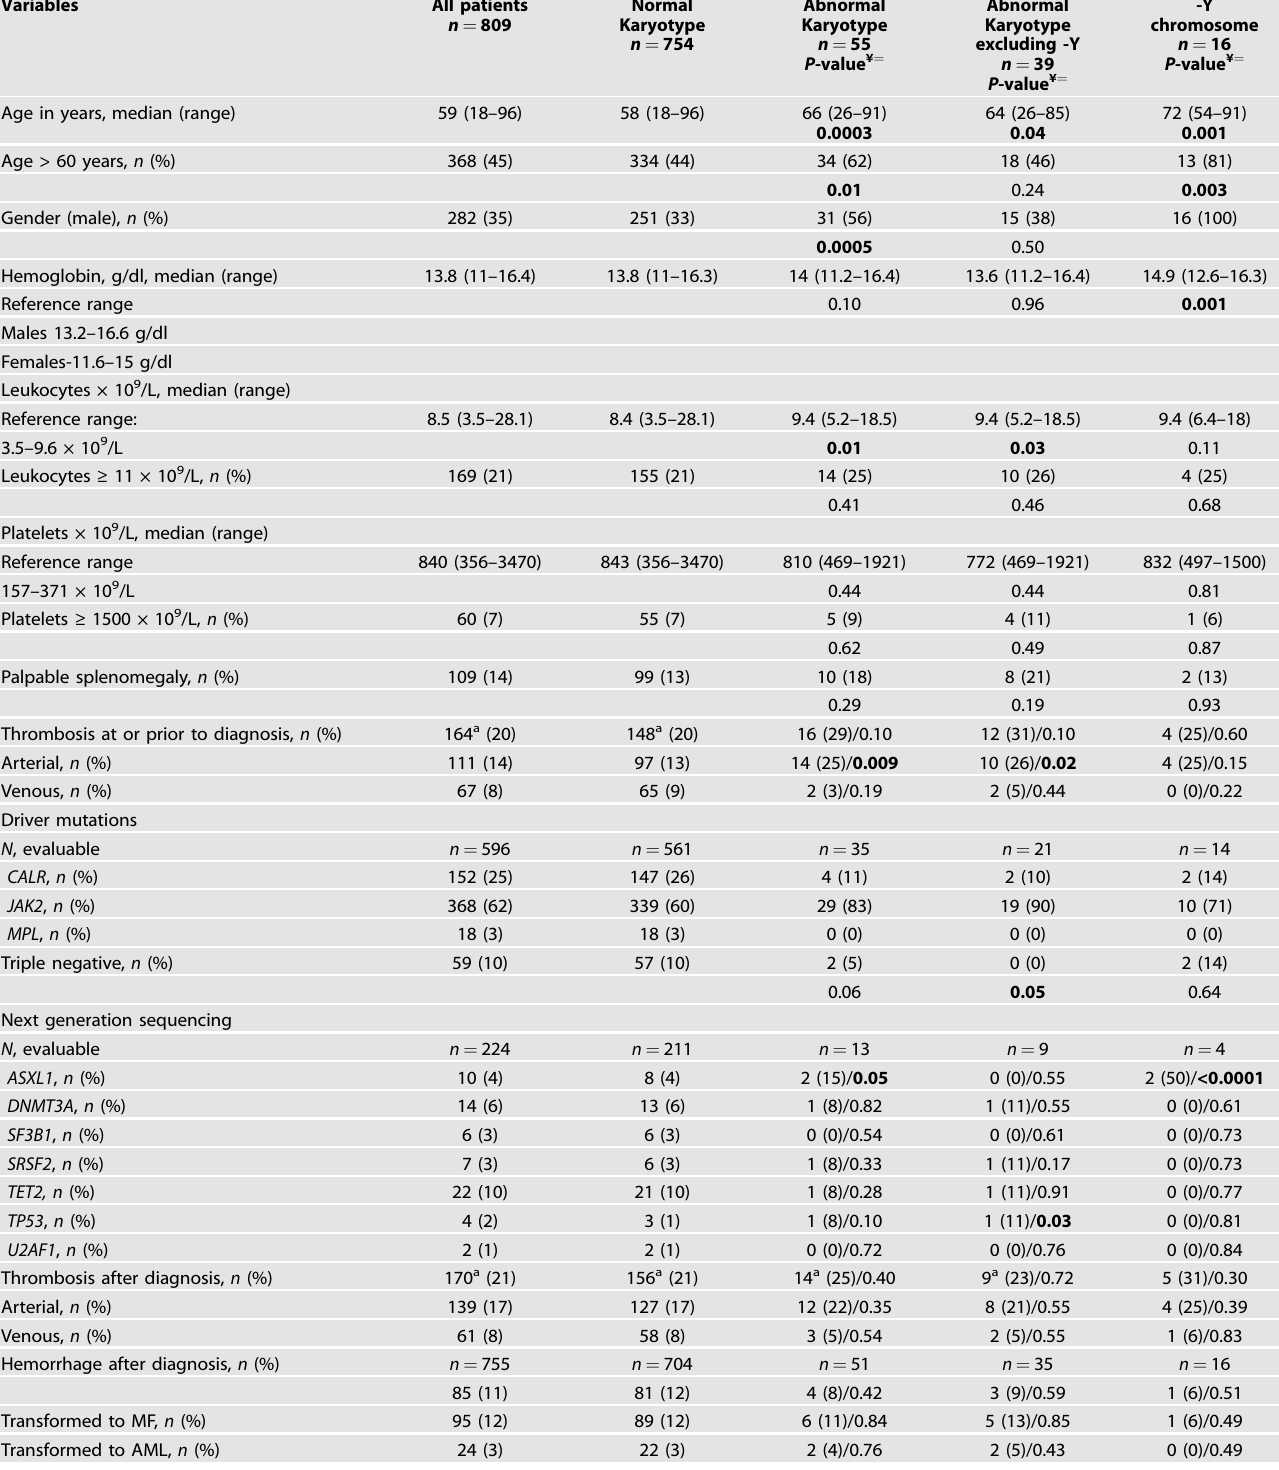
Table 2. Clinical and laboratory characteristics of 809 patients with Essential Thrombocythemia (ET), strati fi ed by cytogenetic